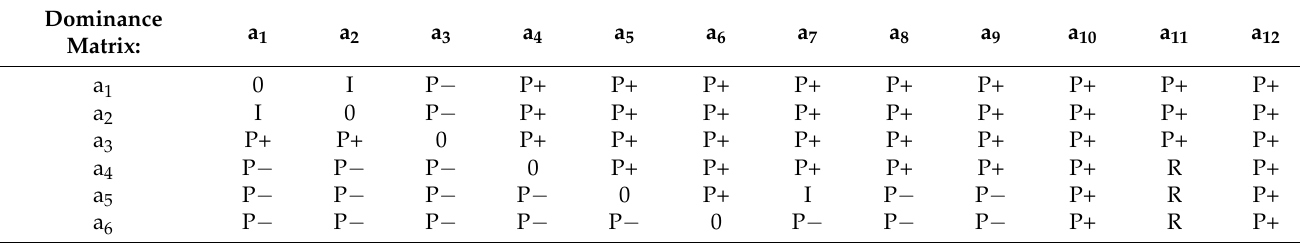
Table 7. Dominance matrix